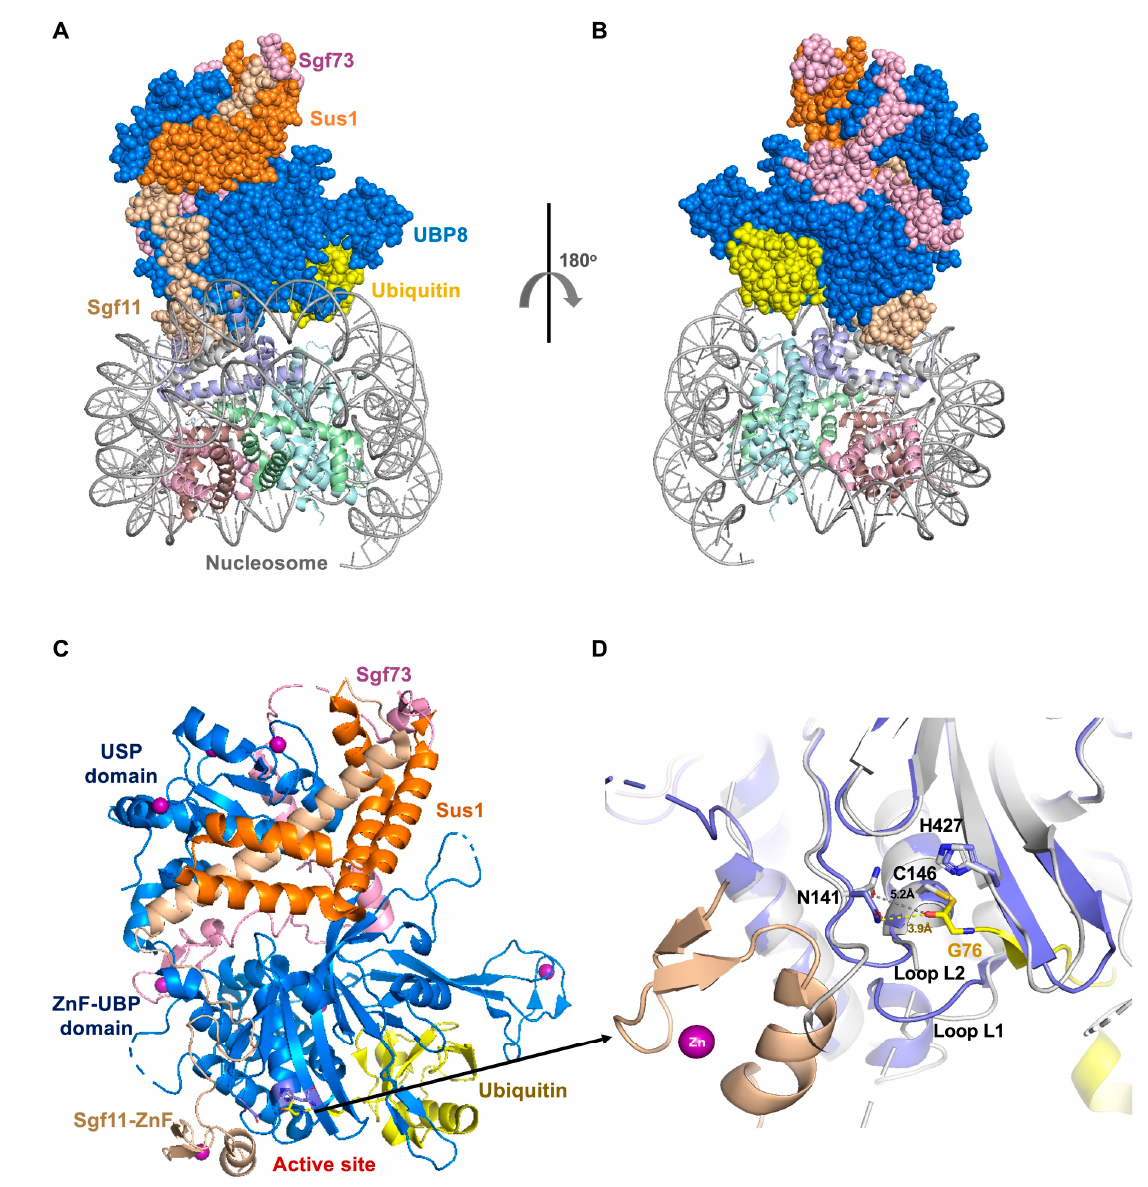
Figure 2. The structure of Ubp8 in the SAGA deubiquitinating module. ( A ) Crystal structure of the SAGA DUB module in complex with monoubiquitinated nucleosome (PDB: 4ZUX). ( B ) View of the complex rotated 180°. ( C ) Structure of Ubp8/Sgf11/Sus1/Sgf73 bound to ubiquitin aldehyde (PDB: 3MHS). ( D ) Zoom-up and superposition of the active site with or without the Sgf11-ZnF domain. Ubp8 (blue), Sus1 (orange), Sgf73 (pink), sgf11 (wheat), ubiquitin (yellow), zinc atom (purple) (PDB: 4FJC and 3MHS).